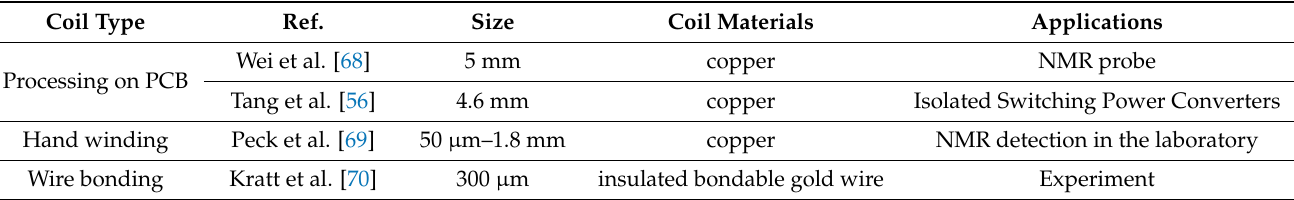
Table 1. A summary of some examples of typical processing